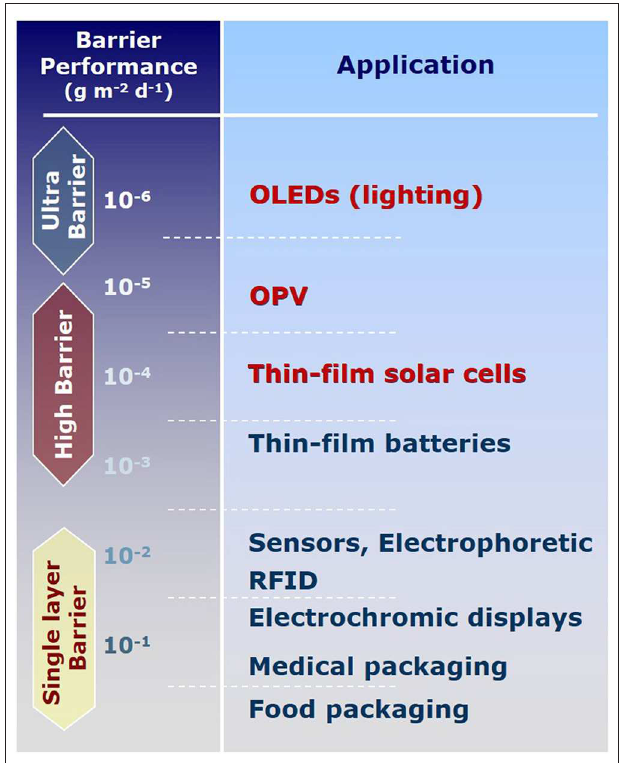
FIGURE 1 | Target water vapor transmission rates for different areas of